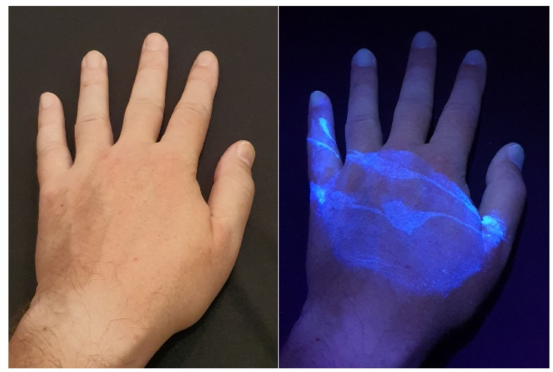
Figure 11. UV light applied in a dark room to reveal marks on the skin left by a pepper